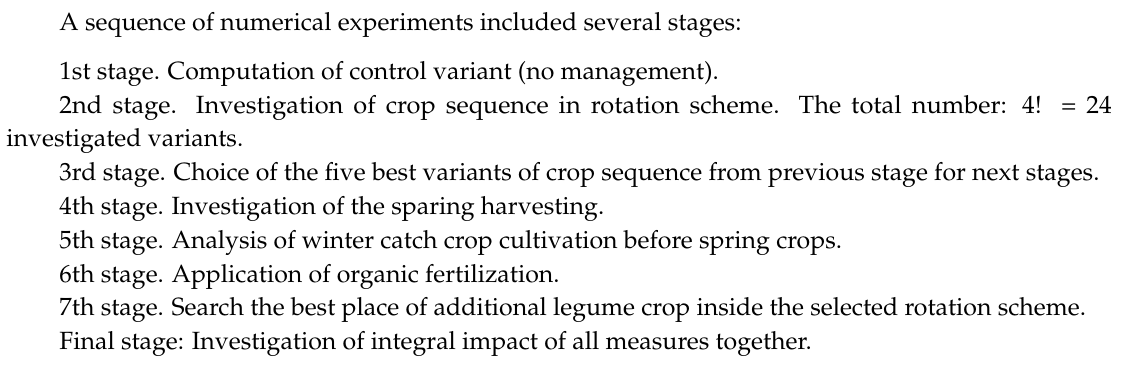
Figure 7. The tested sparing measures.